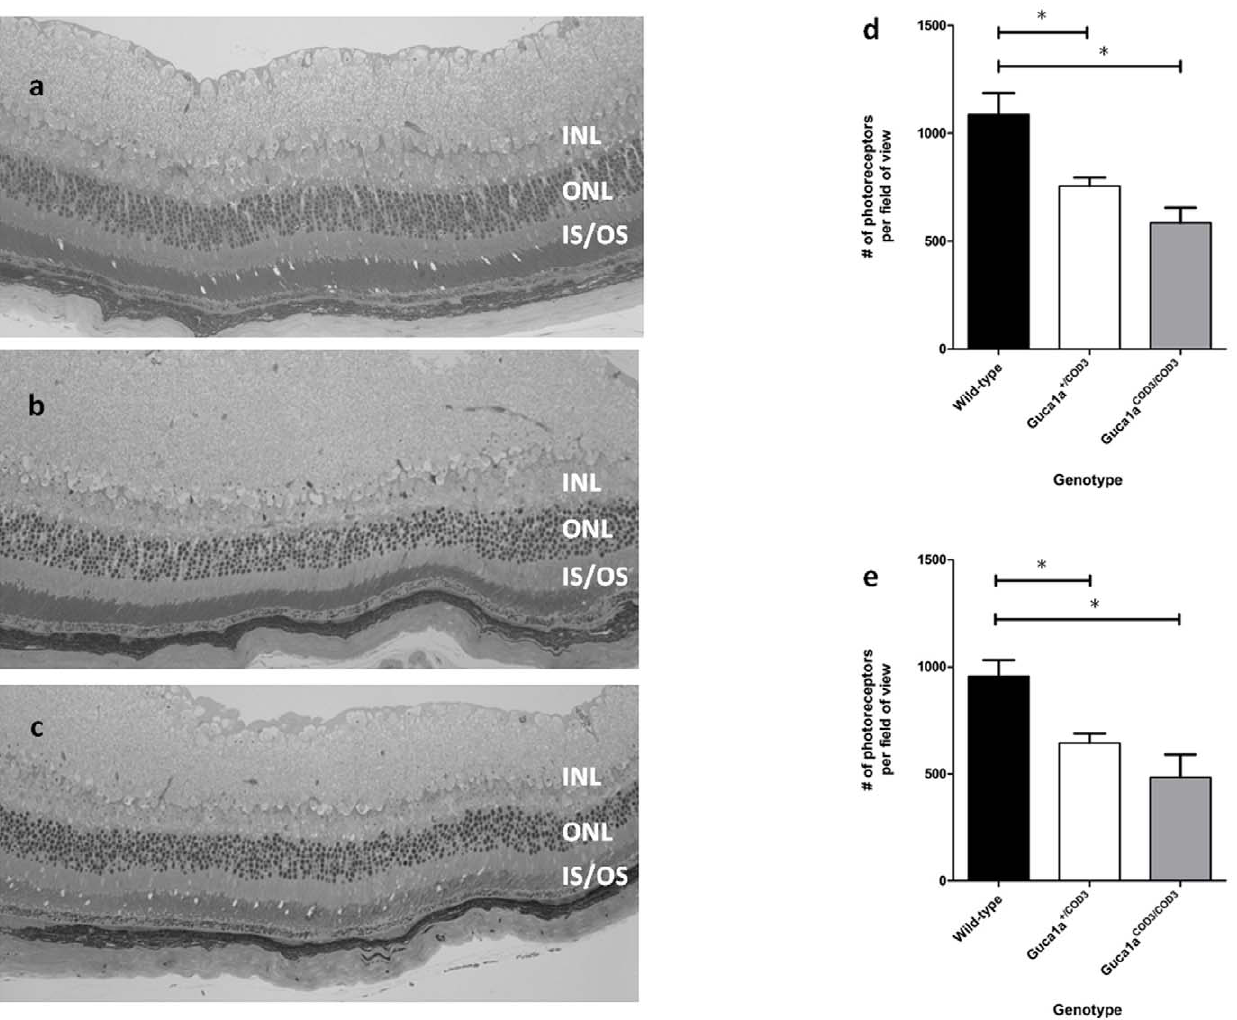
Figure 8. E155G mutation in GCAP1 causes photoreceptor degeneration. Photomicrographs of resin-embedded sections from ( a ) wild-type ( b ) Guca1a + /COD3 , and ( c ) Guca1a COD3/COD3 mice at five months of age. There is a marked thinning of the outer nuclear layer (ONL) in mutant eyes as shown by the loss of photoreceptor nuclei. There is also an apparent shortening of outer segment length, particularly in the Guca1a COD3/COD3 homozygous mice. Photoreceptor loss in Guca1a + /COD3 and Guca1a COD3/COD3 mice was quantified by counting photoreceptor nuclei in photomicrographs of sections from paraffin-embedded eyes taken at fixed positions around the optic nerve. At five months of age ( d ), there is 30% loss in Guca1a + /COD3 and a 46% loss in Guca1a COD3/COD3 mice. At 12 months of age ( e ), this has progressed to a 32% loss in Guca1a + /COD3 and a 49% loss in Guca1a COD3/COD3 mice. * indicates statistical significance at the 1% probability level. Note that in the lower panels of (a), PNA shows non-cone staining above the ONL and INL. INL inner nuclear layer, ONL outer nuclear layer, IS/OS inner segment/outer